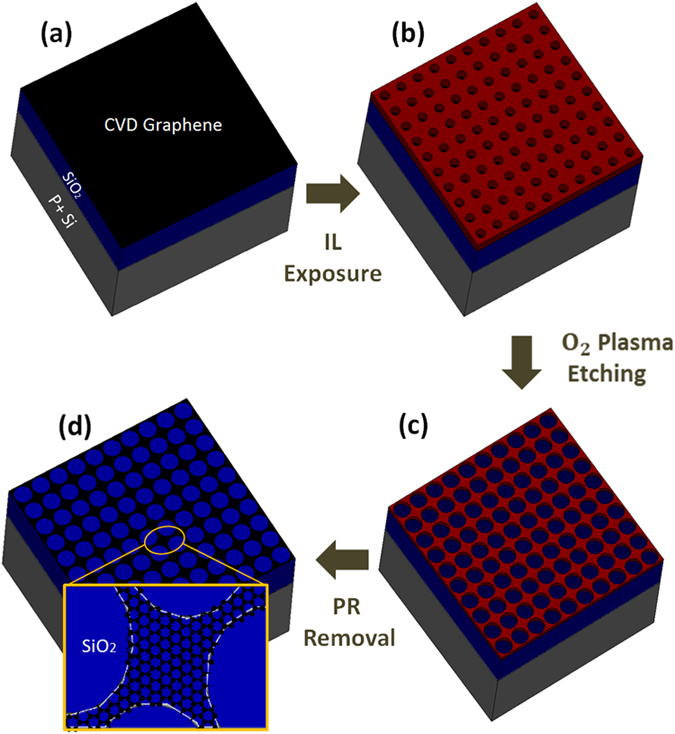
The overall fabrication route of GNM, based on interferometric lithography and O2 plasma etching.(a) SL-CVD graphene on 285 nm-thick SiO2 layer and P + Si substrate. (b) The sample is covered with a spin-coated negative photoresist (PR). A square 2D hole array pattern is made in the PR by IL. (c) To define the mesh structure, an isotropic O2 plasma etching is performed at high pressures. During the O2 plasma step, the PR line width is reduced, which leads to a decrease in the graphene width under the photoresist. (d) The PR mask is removed after a brief soak in acetone solution.